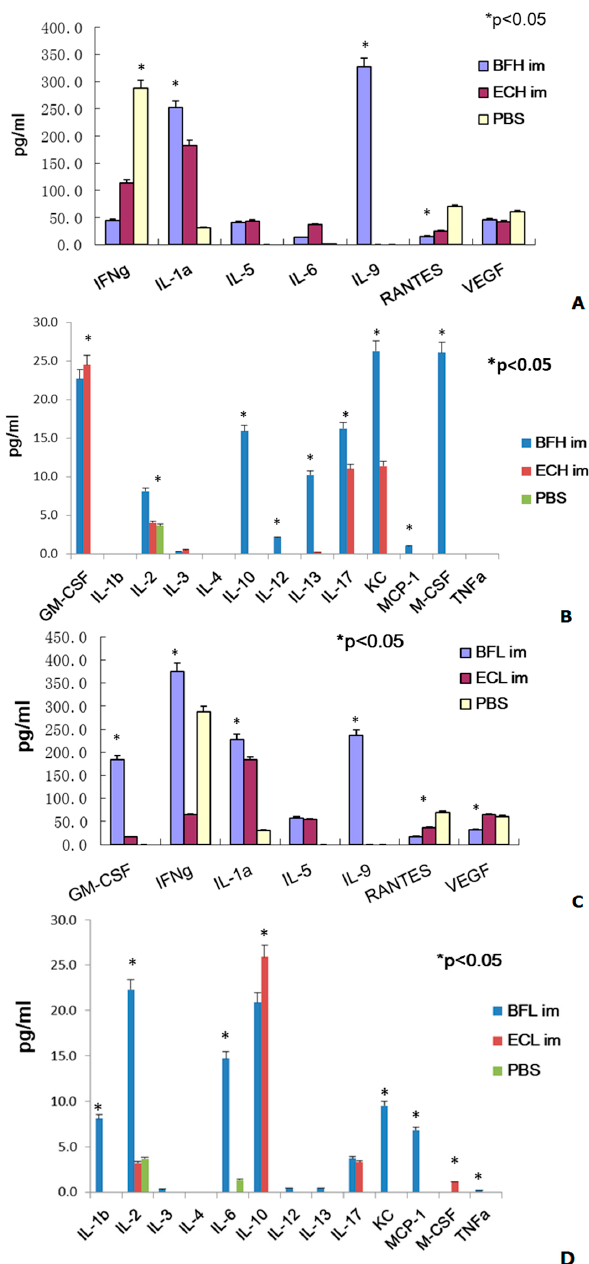
Figure 2. Comparing the cytokine profiles differentiation between BF-rTK and E. coli in BALB/c mice via intramuscular (IM) ( n = 6). ( A ) Cytokine levels expressed in IM group with high dose of bacteria (1.0 × 10 6 cells/mL); ( B ) Cytokine levels expressed in IM group with high dose (1.0 × 10 6 cells/mL); ( C ) Cytokine levels expressed in IM group with low dose of bacteria (1.0 × 10 4 cells/mL); ( D ) Cytokine levels expressed in IM group with low dose of bacteria (1.0 × 10 4 cells/mL). BFH: BF-rTK with high dose (1.0 × 10 6 cells/mL); BFL: BF-rTK with low dose (1.0 × 10 4 cells/mL); ECH: E. coli with high dose (1.0 × 10 6 cells/mL); ECL: E. coli with low dose (1.0 × 10 4 cells/mL); im: intramuscular injection (* p < 0.05). PBS: phosphate buffer saline.